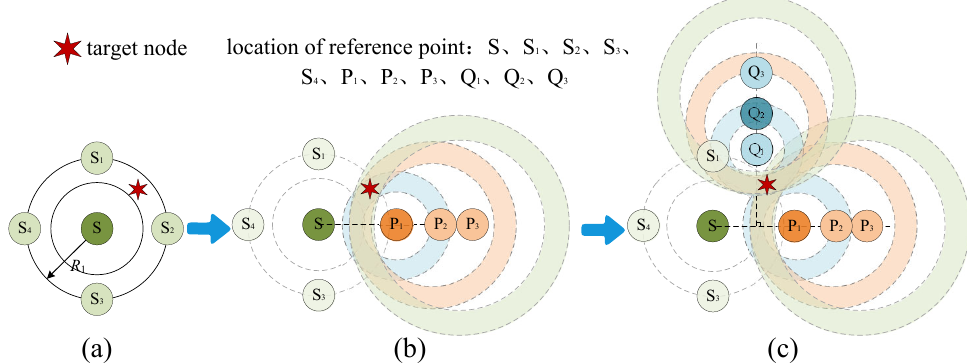
Figure 10. Select reference point. ( a ) Select the first reference point. ( b ) Select the second reference point. ( c ) Select the third reference